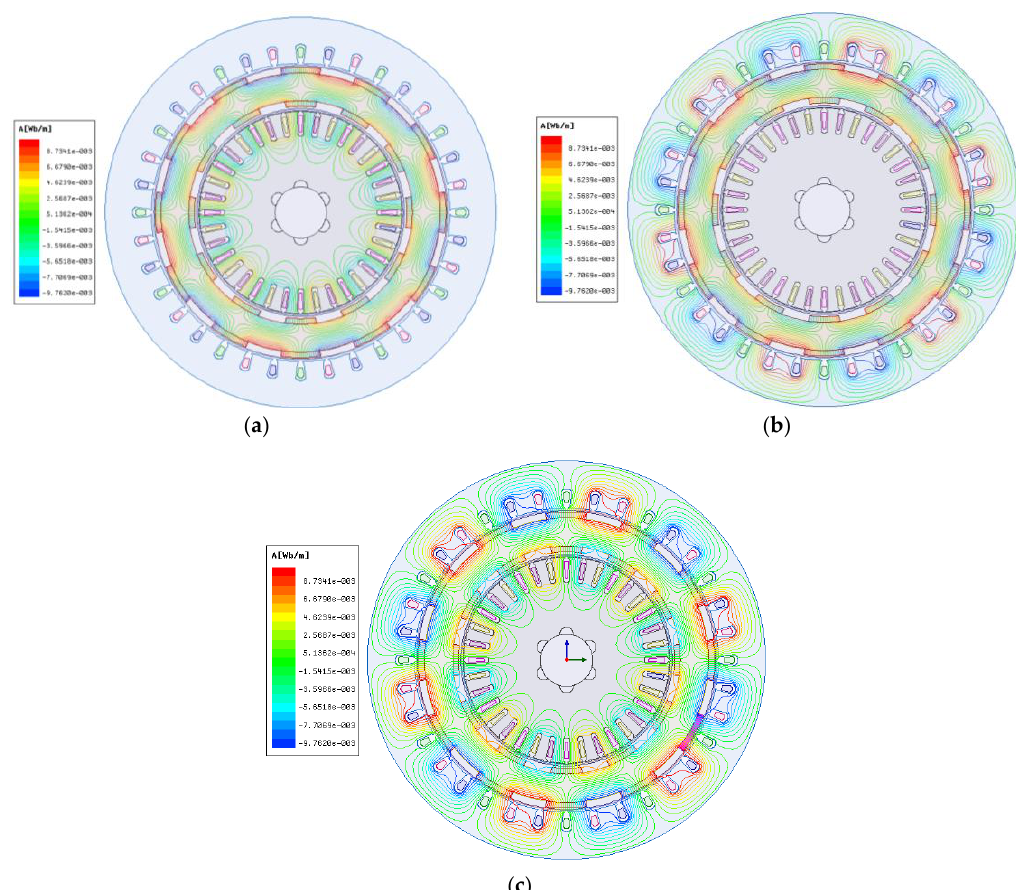
Figure 13. The magnetic flux line distributions of DRM, SM and the CSPM motor: ( a ) DRM; ( b ) SM; ( c ) CSPM motor.